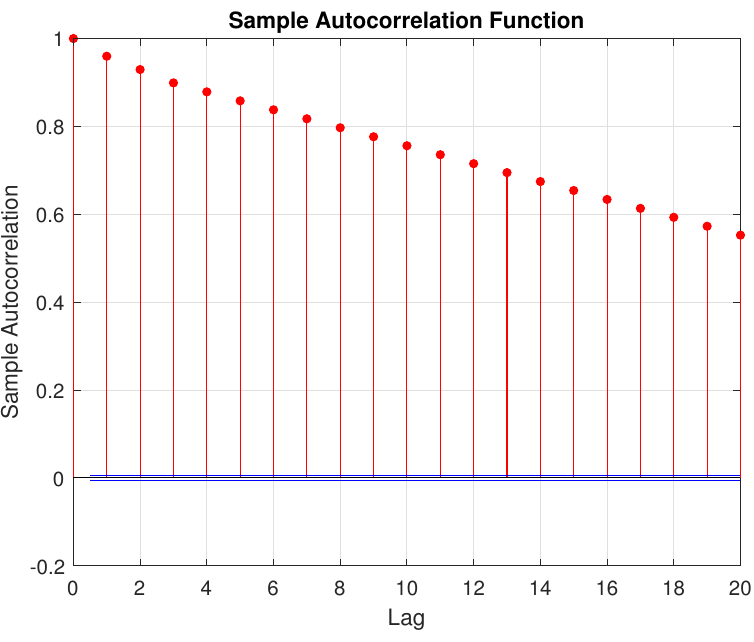
Figure 6. Sample autocorrelation for the level h sump